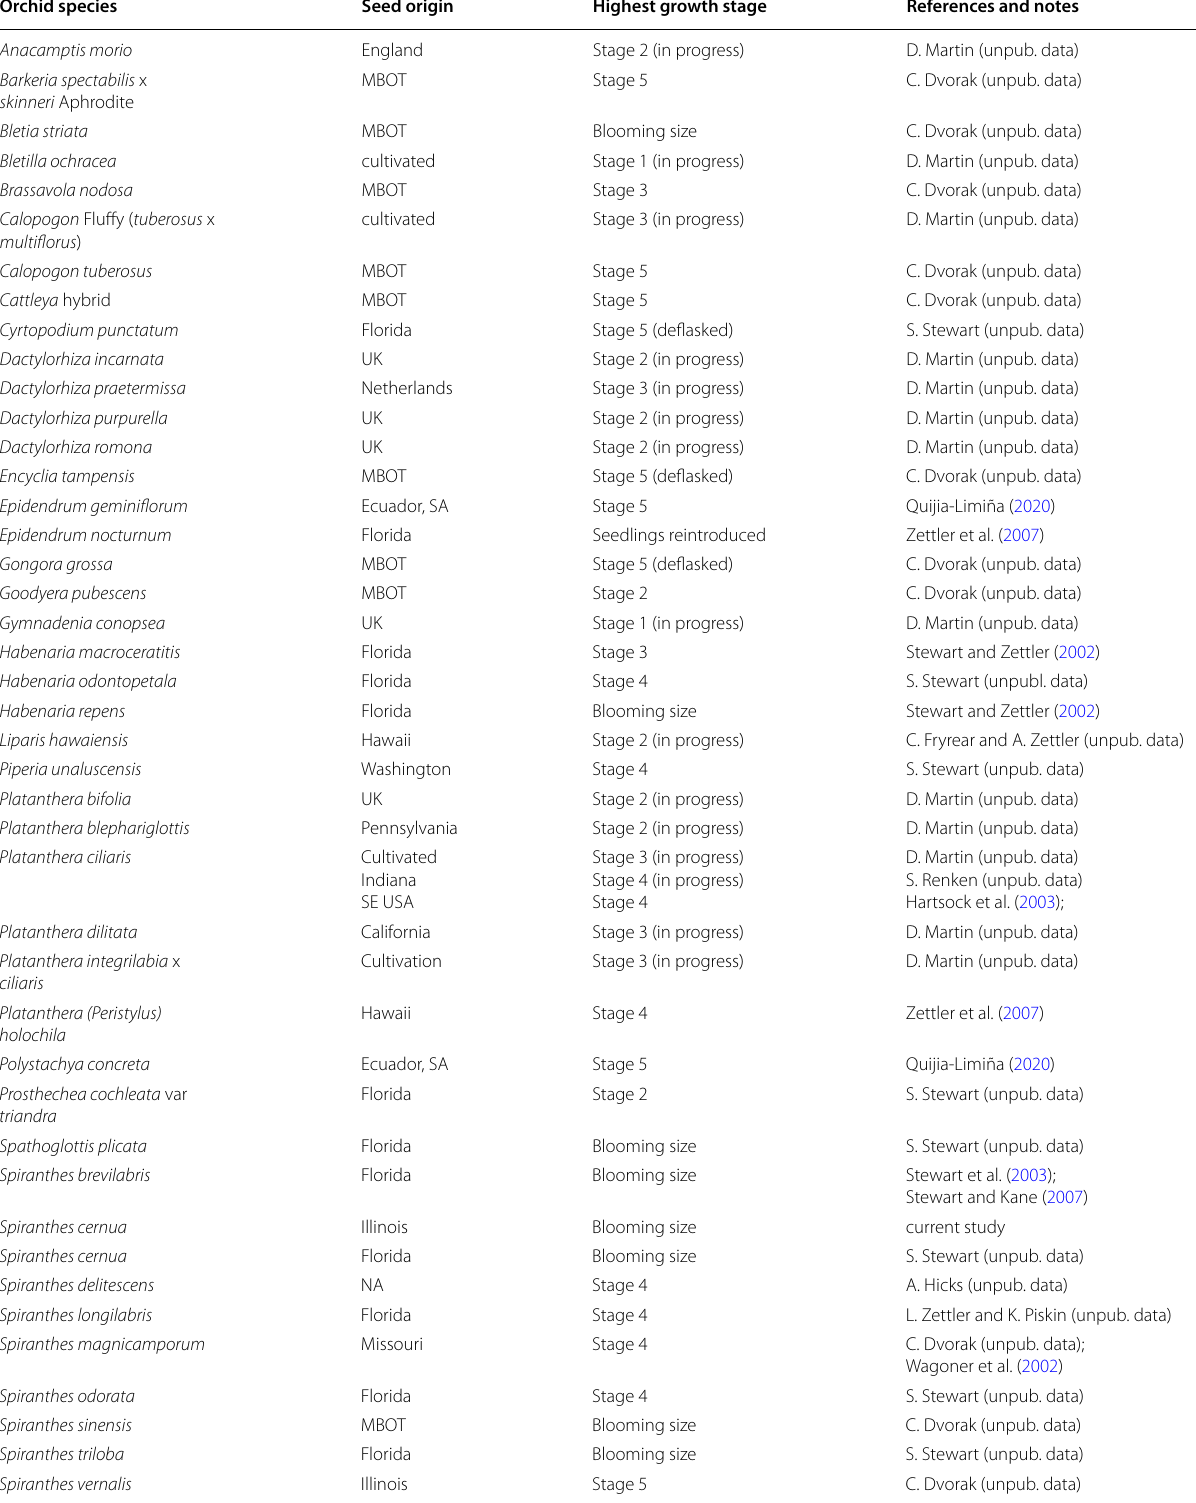
Table 3 A comprehensive list of the orchids propagated from seed in vitro using Tulasnella calospora 266 during the past two decades Orchid